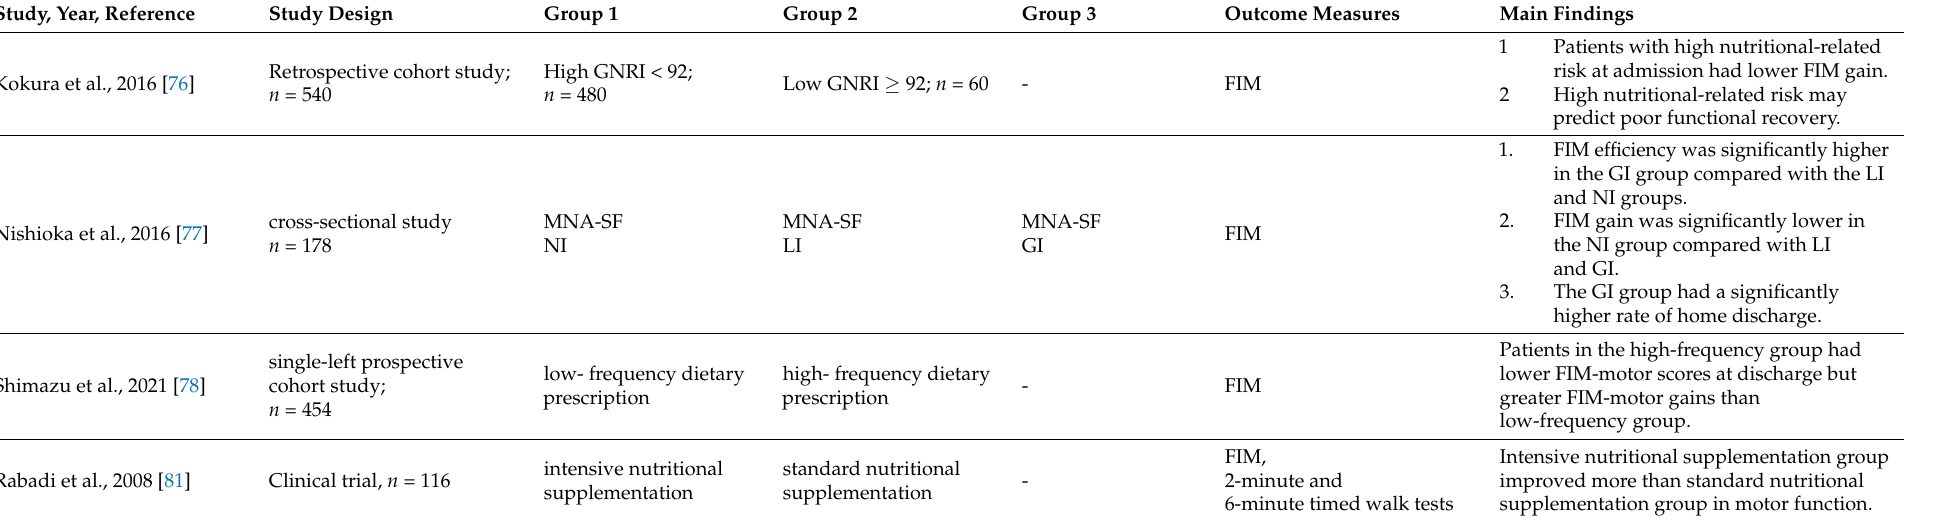
Table 1. The correlation between nutritional status and functional